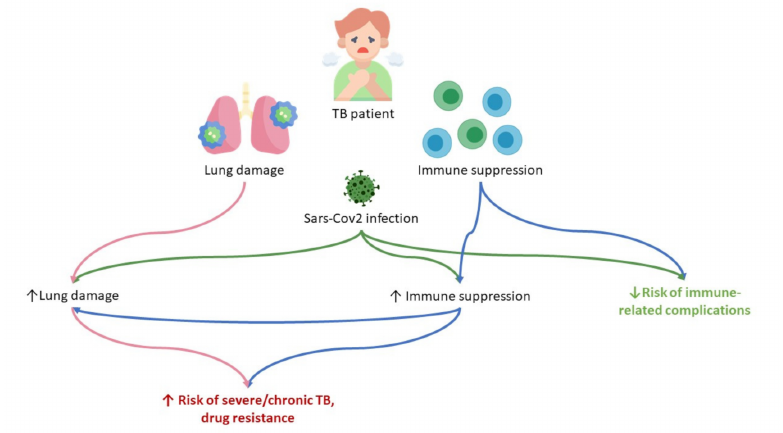
Figure 1. The supposed mechanisms of SARS-CoV-2 infection influence on tuberculosis infection. Tuberculosis infection contributes either lung damage and general immune suppression, which is enforced by SARS-CoV-2 infection and predisposes to the development of severe/chronic tuberculosis with drug resistance. On the other side, the latent immune suppression might be a defending factor against the development of cytokine